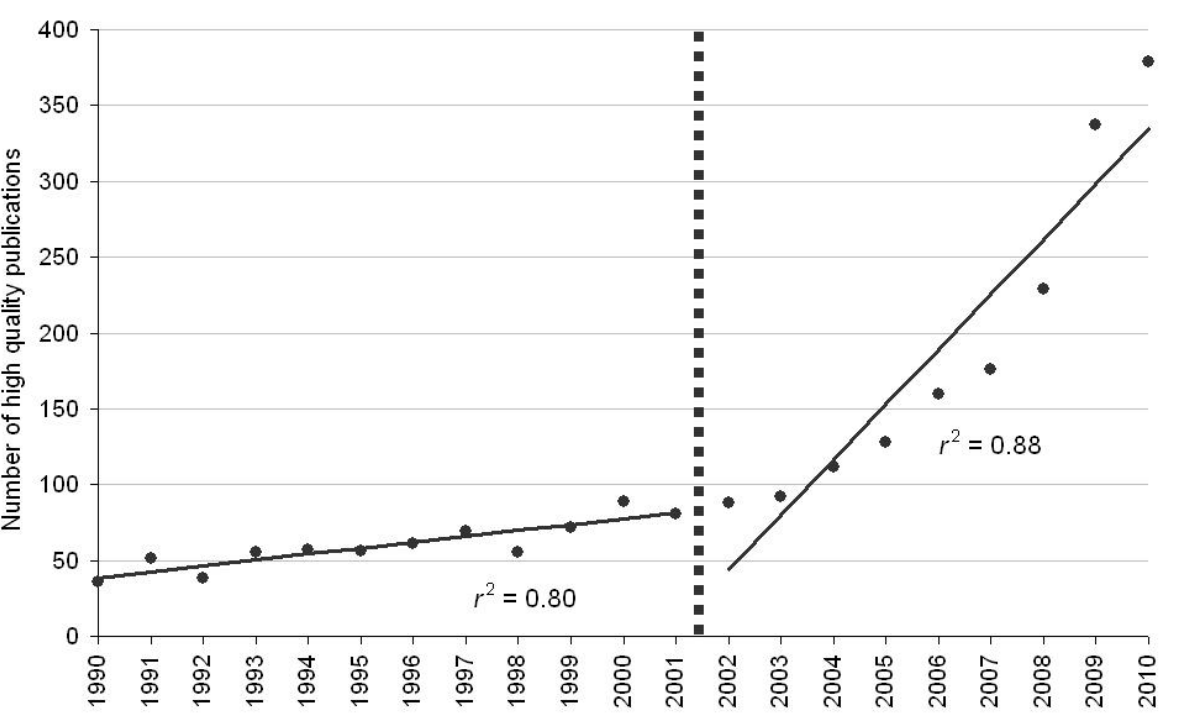
Figure 2. Number of high quality publications by year of